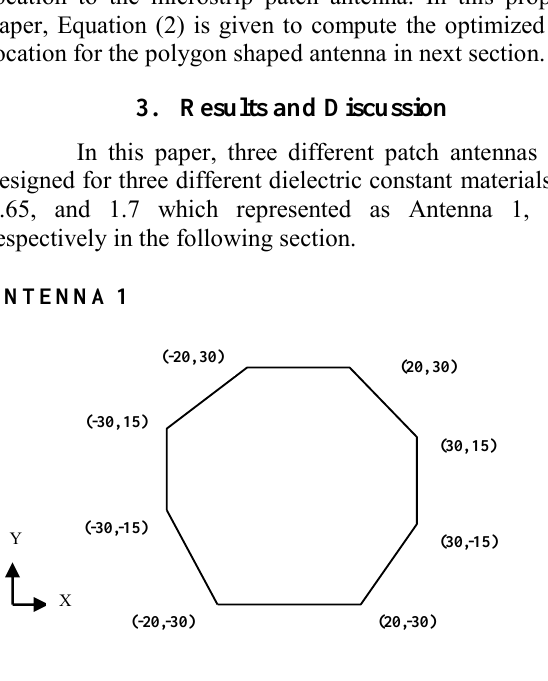
Fig. 1.1 Polygon shaped patch Antenna 1-Topology Topology of the Polygon shaped patch Antenna 1